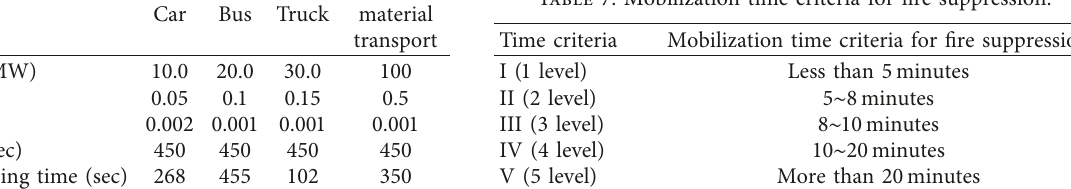
Table 7: Mobilization time criteria for fire